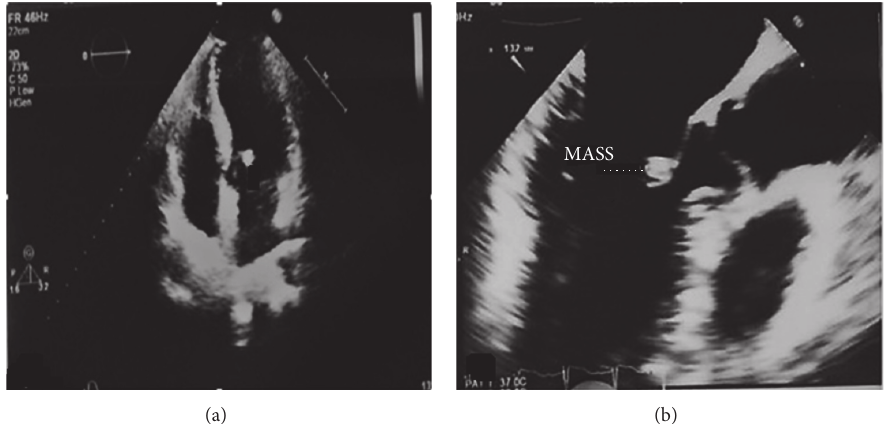
Figure 1: Transesophageal echocardiography showing an echogenic, round, and mobile mass, attached to the atrial surface of the anterior mitral valve leaflet by a short pedicle, measuring 5 × 5mm.